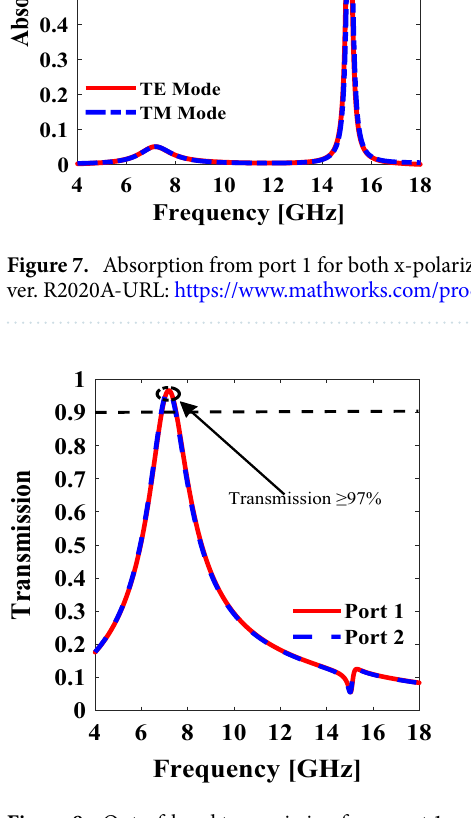
Figure 8. Out-of-band transmission from port 1 and port 2. *The figure is created using MATLAB ver. R2020A-URL: https:// www. mathw orks. com/ produ cts/ matlab.